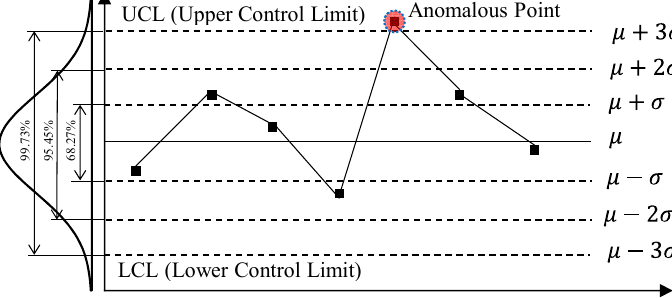
Figure 1. A Schematic Diagram of x–MR Control Chart Method.